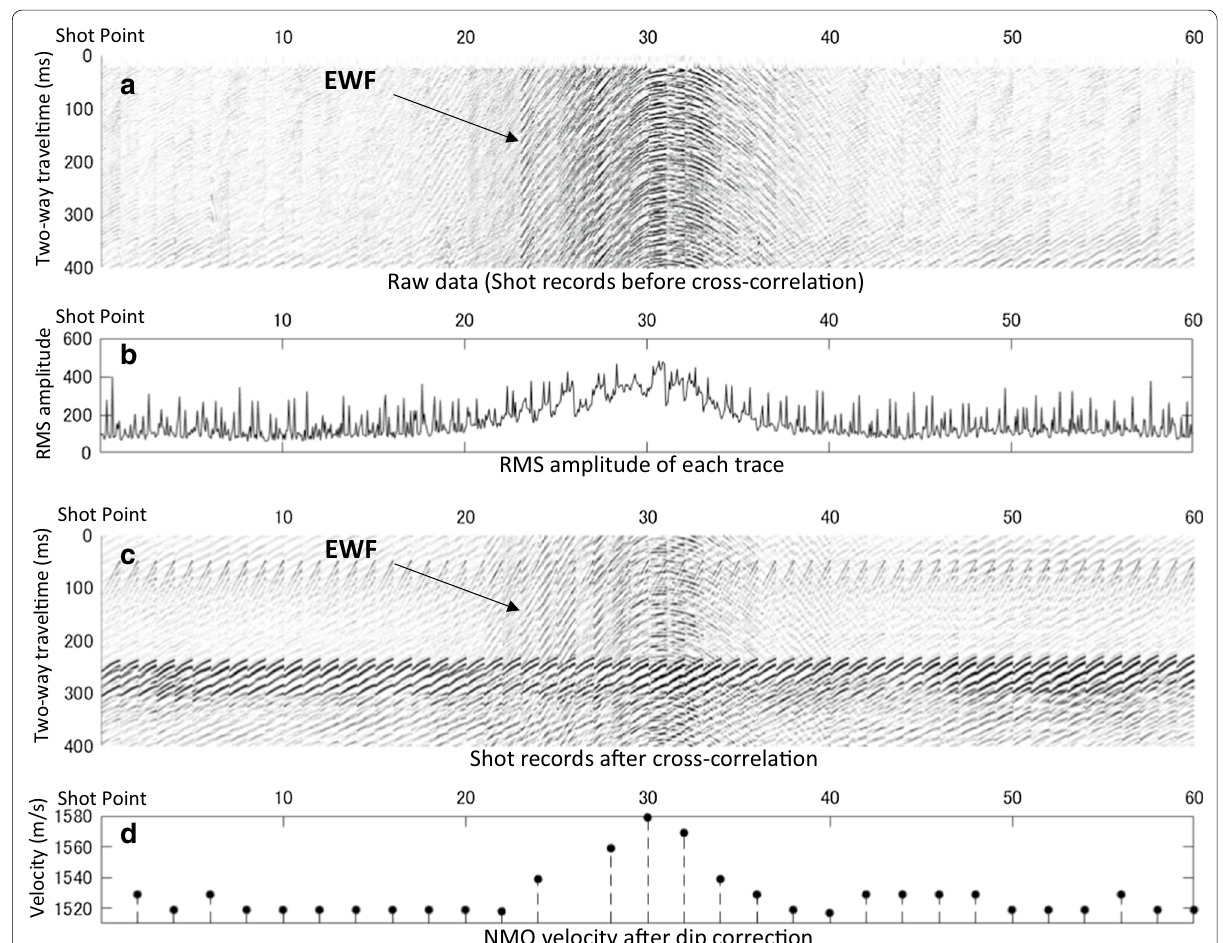
Fig. 6 a EWF observed on the raw field data of line 10. b The rms amplitude of each trace of the raw field data of line 10 is displayed. A relatively high rms amplitude can be seen along the zone of the EWF. c EWF observed on the shot records of line 10. A similar EWF can be observed as that on the raw field data. d NMO velocities estimated on line 10. Dip correction has been conducted by using Levin (1971)